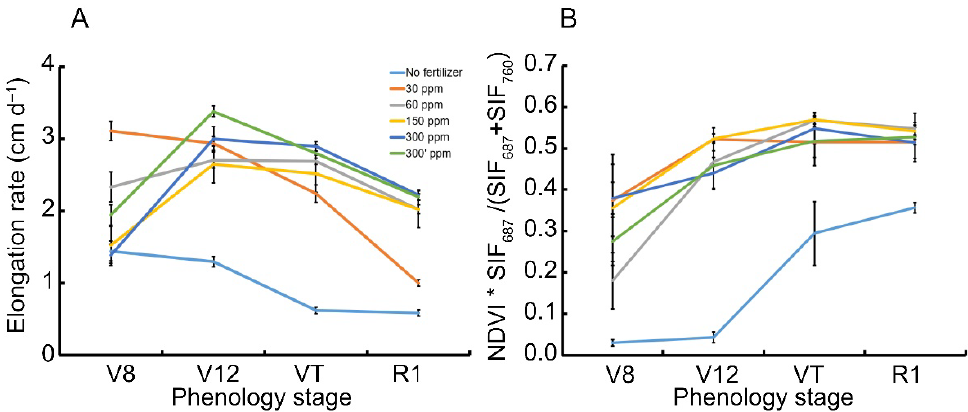
Figure 3. RS-ETRi index attenuation compared to the elongation rate of Z. mays (‘Super sweet’, sh2) along the season. Colors in both panels ( A ) and ( B ) represent fertilization treatments where light